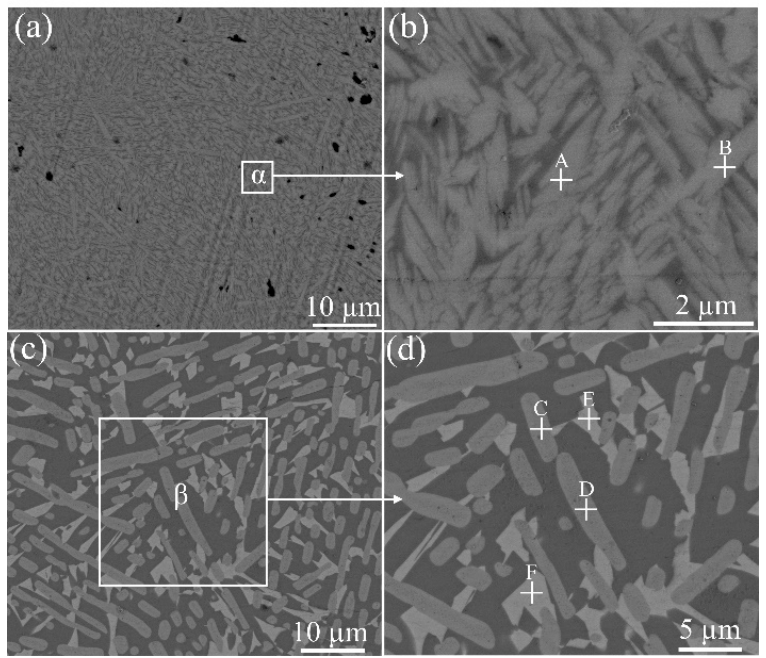
Figure 1. ( a ) Morphology of the glass heat treated at 477 °C and ( b ) high magnification morphology of selected area α . ( c ) Morphology of the glass heat treated at 551 °C and ( d ) high magnification morphology of selected area β .